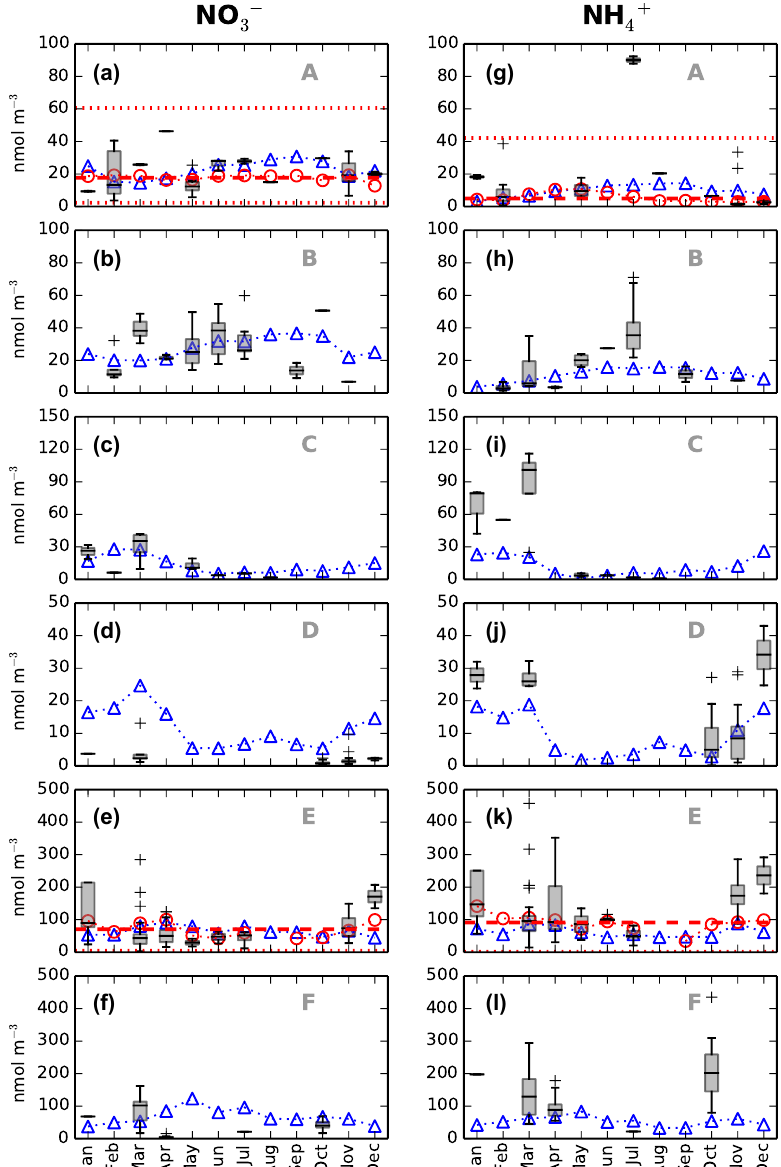
Figure 3. Box-and-whisker plots, showing the distribution of aerosol NO − (left) and NH + (right) concentrations (nmolm − 3 ) in selected grid 3 4 cells from the TEAtl, NInd and NWPac regions. Upper and lower limits of boxes represent the interquartile range of data in each category, with the median shown as bars in each box. Whiskers represent the range of the data, except where extremes (values greater than 1.5 times the interquartile range above the upper quartile) were present (crosses). Instances where only one data point was available for a given month are shown as a solid bar. Summaries of longer-term aerosol sampling records for the Cabo Verde islands (a, g) and Pengchiayu Island (e, k) are also shown. In those panels, red dashed and dotted lines represent the mean, minimum and maximum concentrations of all the island data, while open circles represent the monthly mean concentrations for all of the observations in each island record. Monthly mean concentrations from the TM4 model are shown for each cell as blue triangles. Locations of the cells A–F are shown in Fig.